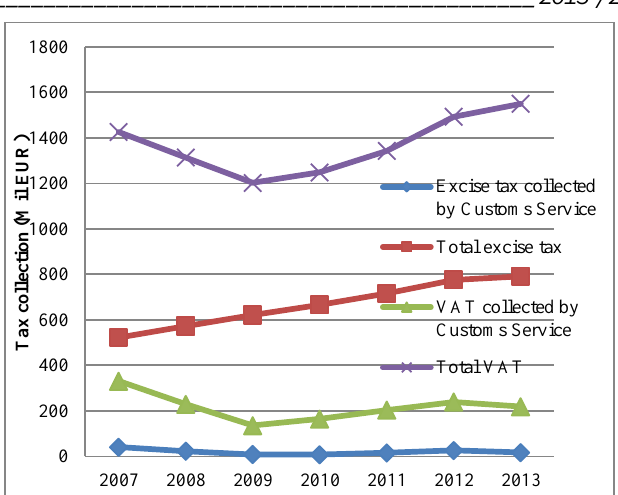
Fig. 5. VAT applied and excise tax collected by Customs Service of Estonia. Source : Estonian Tax and Customs Board. Statistics.